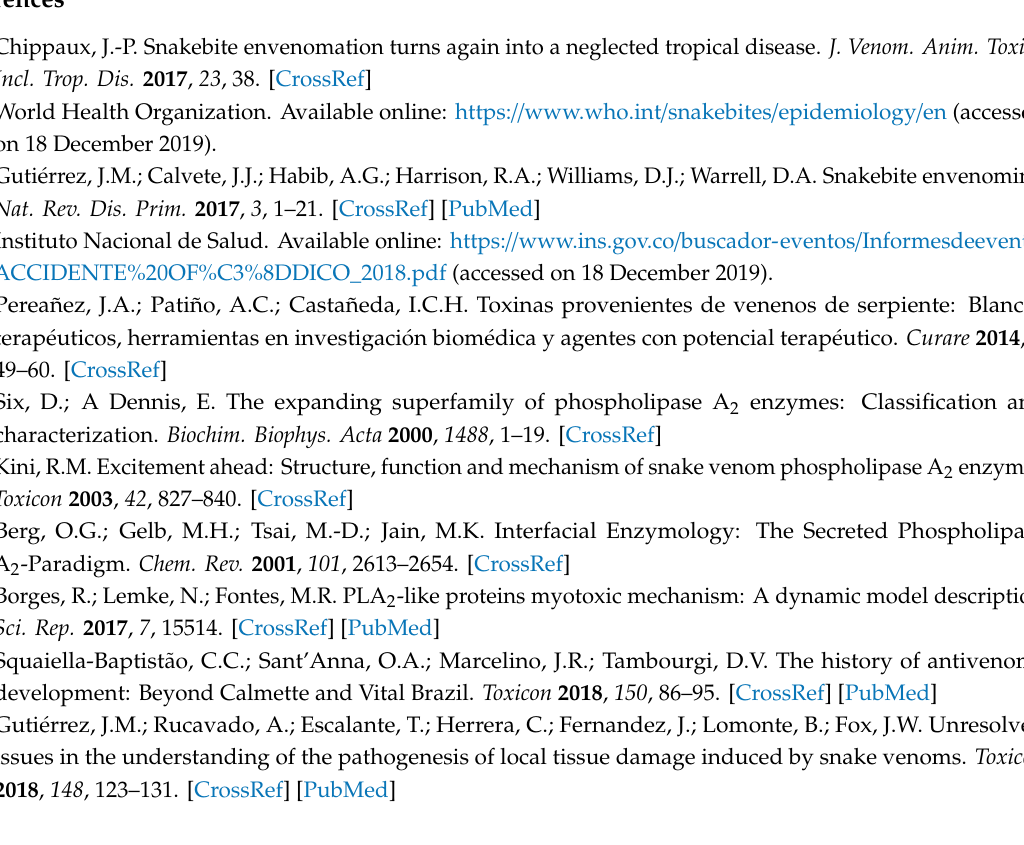
Supplementary Materials: The following are available online, Table S1: Homologous experimental and calculated (B3LYP / 6-31 + G(d,p)) intra-molecular bond distances (Å) and angles ( ◦ ) of Benzyl 4-nitrobenzenecarbodithioate (I)., Figure S1: 1 H NMR Spectrum of I Benzyl 4-nitrobenzenecarbodithioate, crude product., Figure S2: 13 C NMR Spectrum of I Benzyl 4-nitrobenzenecarbodithioate, crude product., Figure S3: IR Benzyl 4-nitrobenzenecarbodithioate